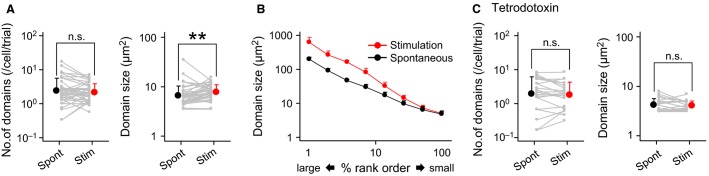
Visual stimulation induces larger calcium domains. (A), The mean number of calcium domains in a single cell per trial (left) and the mean size of individual domains (right) are compared between spontaneously emerging domains (Spont) and visually activated domains (Stim). Error bars are the SDs of 39 cells. Each gray line indicates a single astrocyte. **P = 0.009, paired t-test. (B), Percentage rank orders of the sizes of 5236 (Stimulation) and 720 (Spontaneous) domains. (C), Same as A, but for tetrodotoxin-treated visual cortex. n = 21 astrocytes.